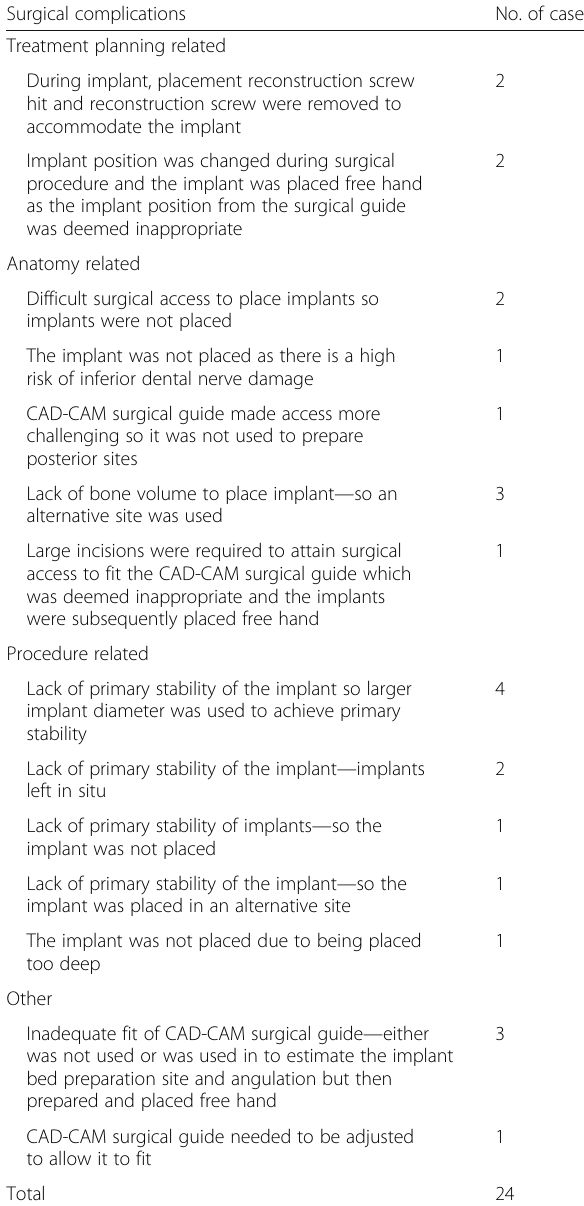
Table 7 Surgical complications reported during implant placement Surgical